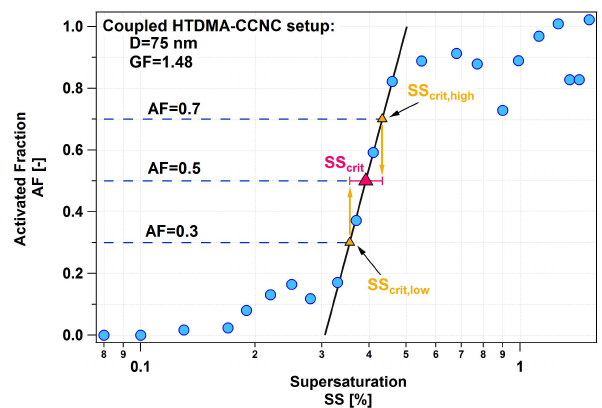
Fig. 3. Illustration of the approach to determine SS crit ( D ,GF) from the activation curves measured with the coupled HTDMA-CCNC setup. This example is for a dry size of 75nm and a GF of 1.48. The black line is fitted to the data in the range AF = 0.3–0.7. The purple tringle shows SS crit ( D ,GF) at AF = 0.5 and the purple error bars indicate the SS range between AF = 0.3 and AF =